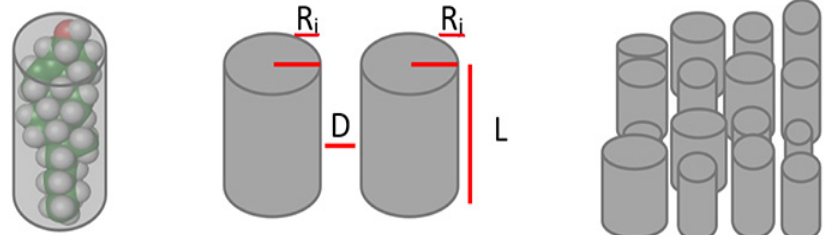
Figure 7. Lipid groups representation. Lipid molecules are simplified as the cylinder that best fits their volume and then are parameterized by their radiuses (Ri, Rj), length (L) and mean distance in between (D). Finally, cylinders are disposed in a 2D matrix at appropriate densities to simulate the cell membrane monolayer [24].